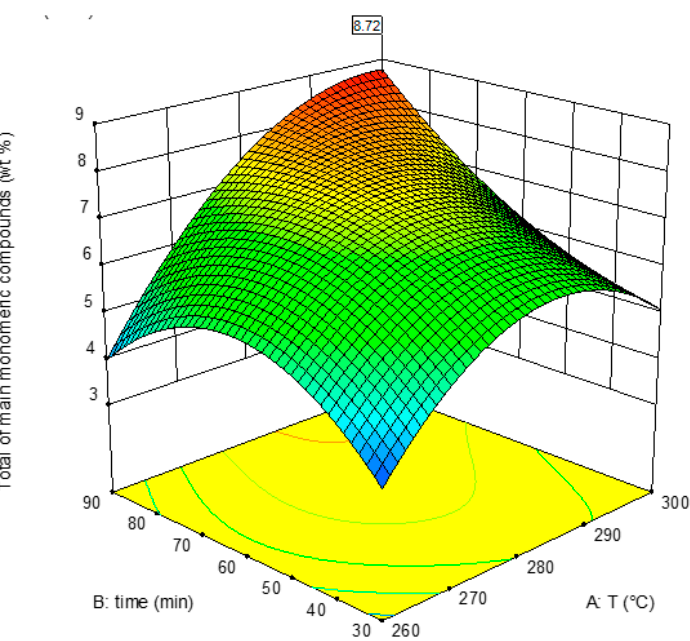
Figure 8. Prediction of the production of the monomeric compounds at different conditions of temperature and residence time.